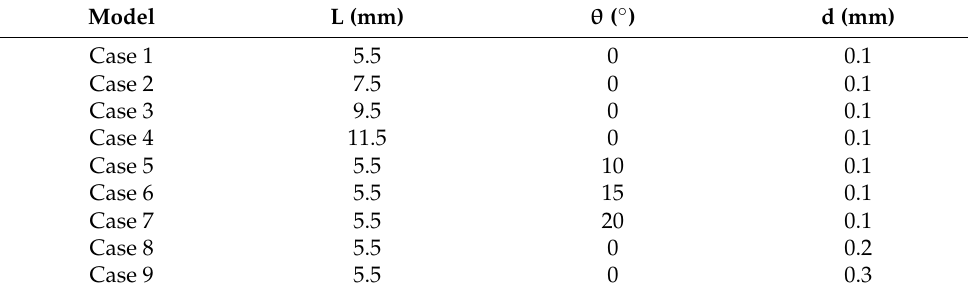
Table 1. Parameters of each